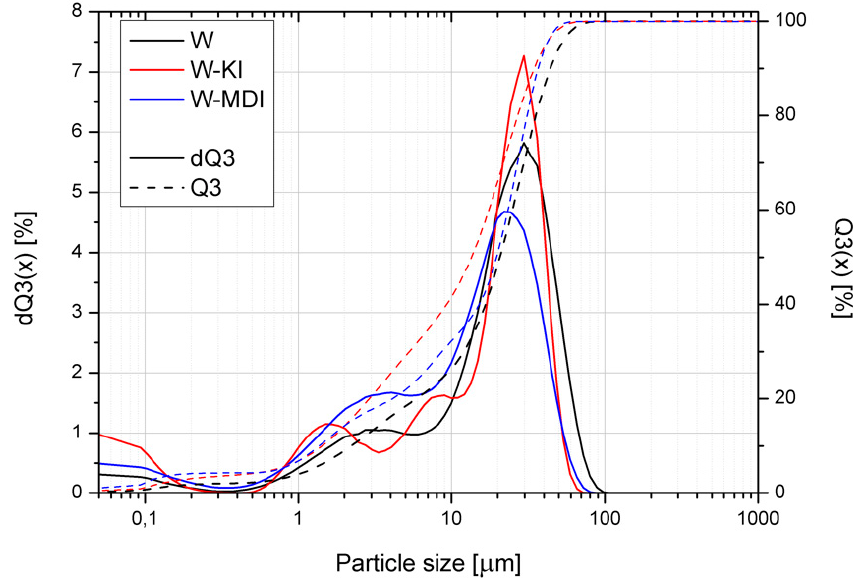
Figure 4. The particle size distribution of vermiculite before and after mechanochemical modification.